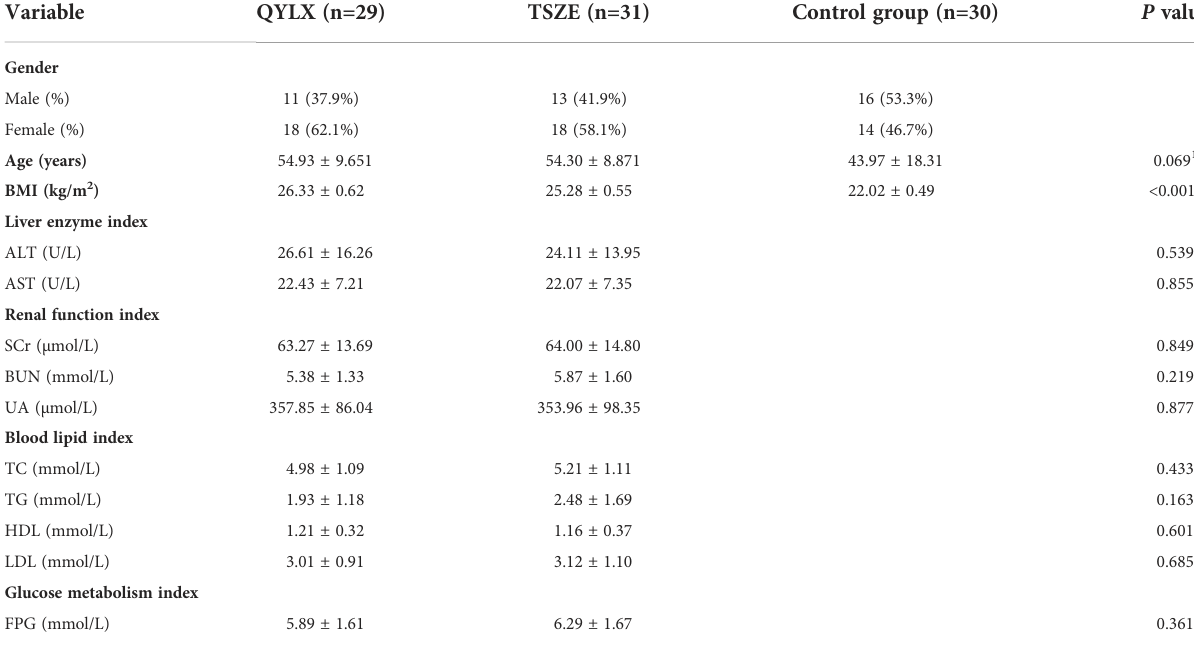
TABLE 1 Comparison of age, sex and clinical indicators between MS patients and control group.